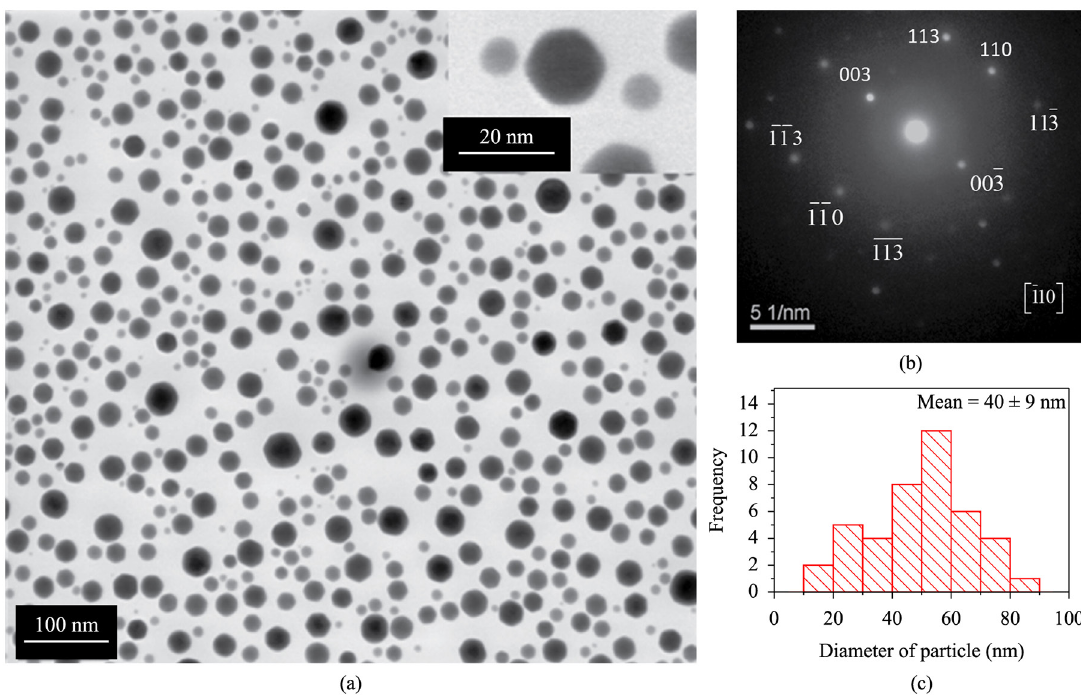
Figure 2. Bright field TEM images of Bi (b) corresponding selected area diffraction pattern and (c) histogram showing particle size distribution.